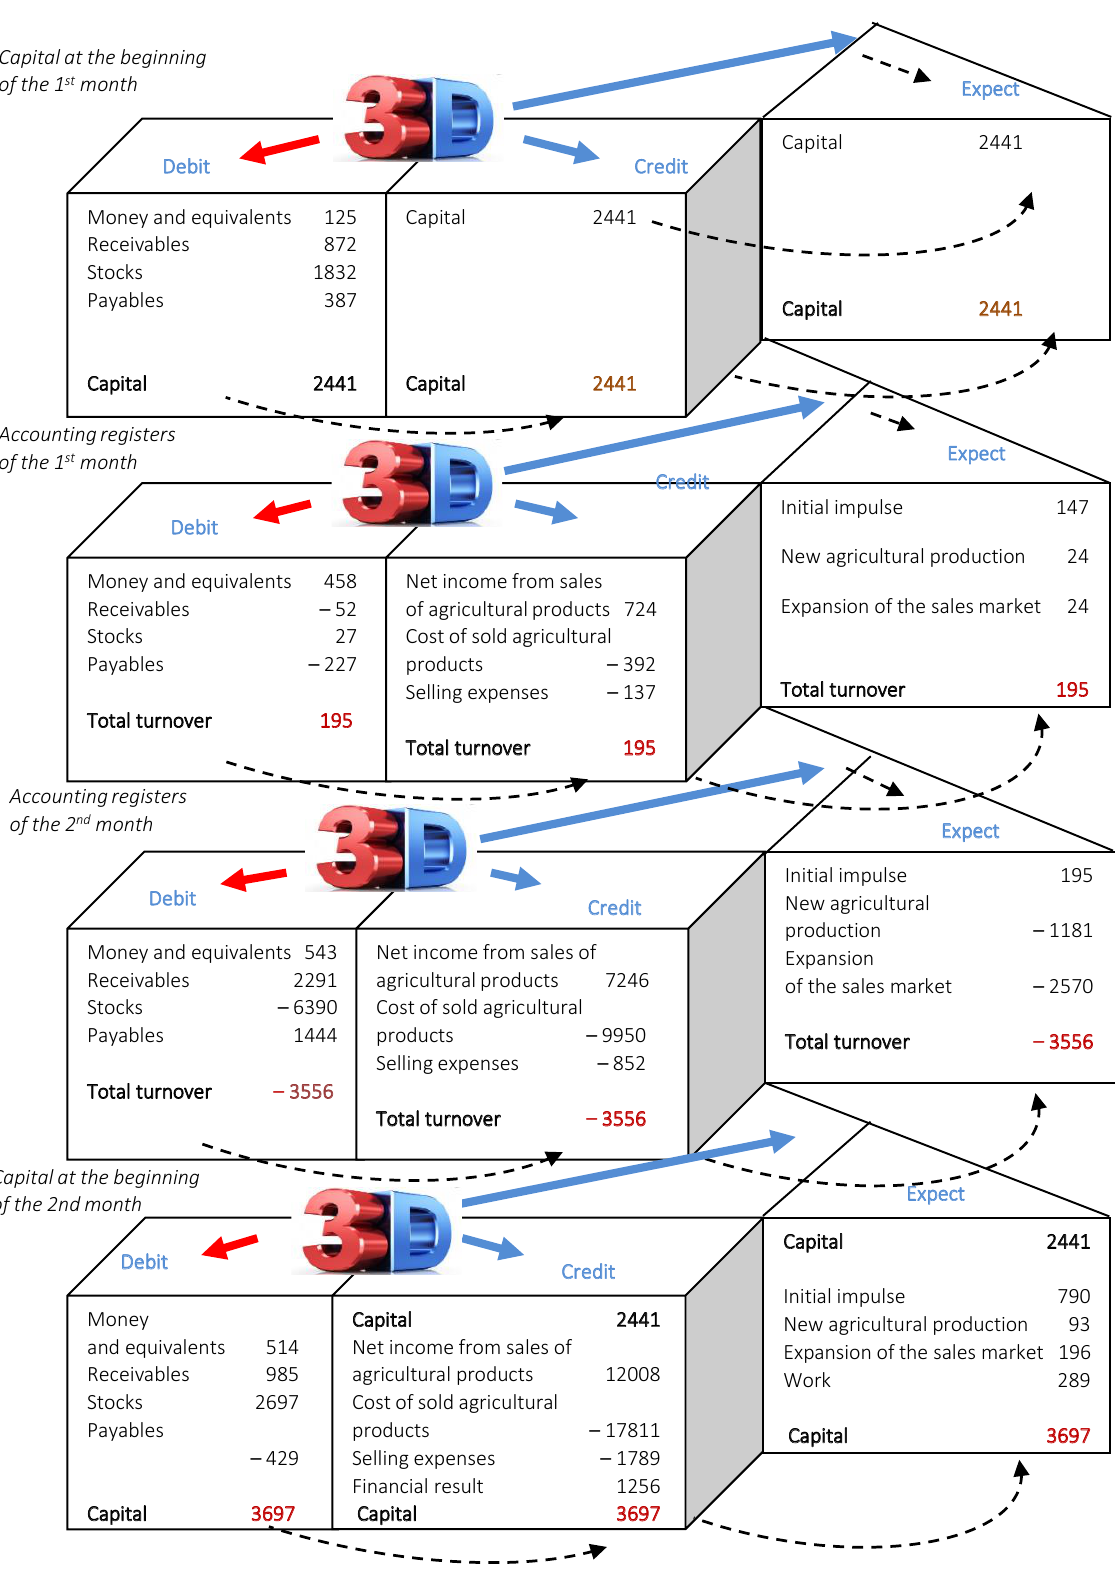
Figure 3. 3D projection of the force impulse of the capital balance of PAO “Agribusiness